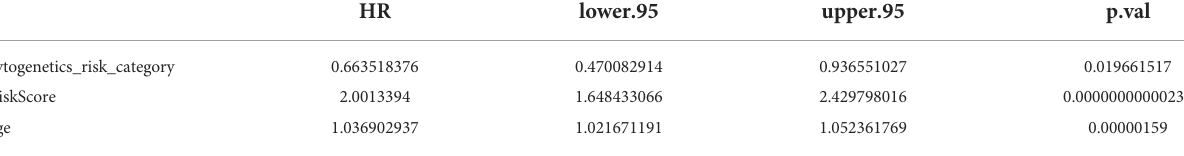
TABLE 4 Multivariate Cox analysis in independent prognostic analysis.